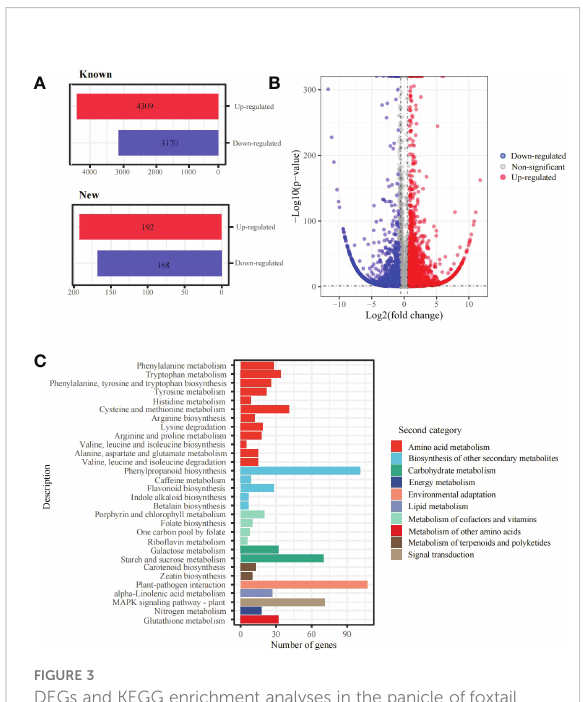
FIGURE 3 DEGs and KEGG enrichment analyses in the panicle of foxtail millet following SA treatment (A) the statistics of new and known DEGs; (B) volcano plot of DEGs between 6mM and 0 mM SA treatment; (C) the KEGG enrichment of